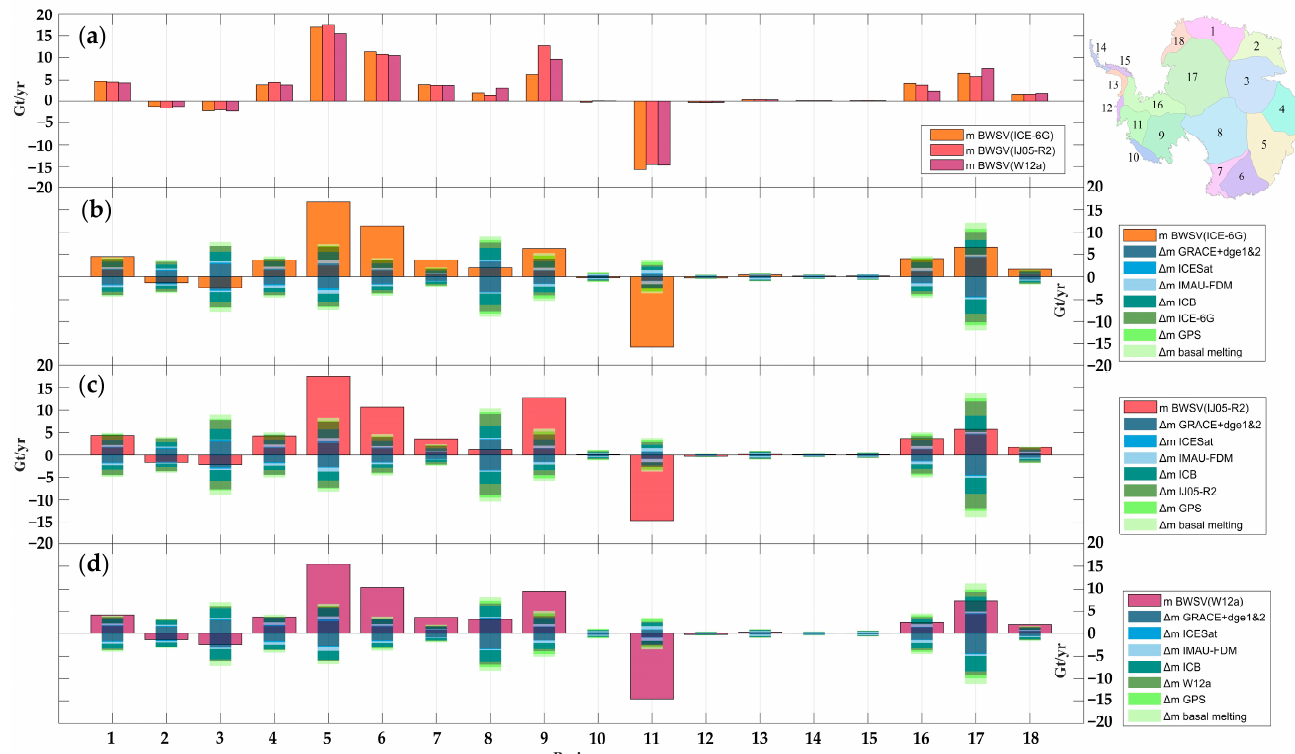
Figure 11. ( a ) Comparison of regional BWSV rates in 18 drainage basins, and ( b – d ) error contributions of input dataset to regional standard deviations of BWSV rates.